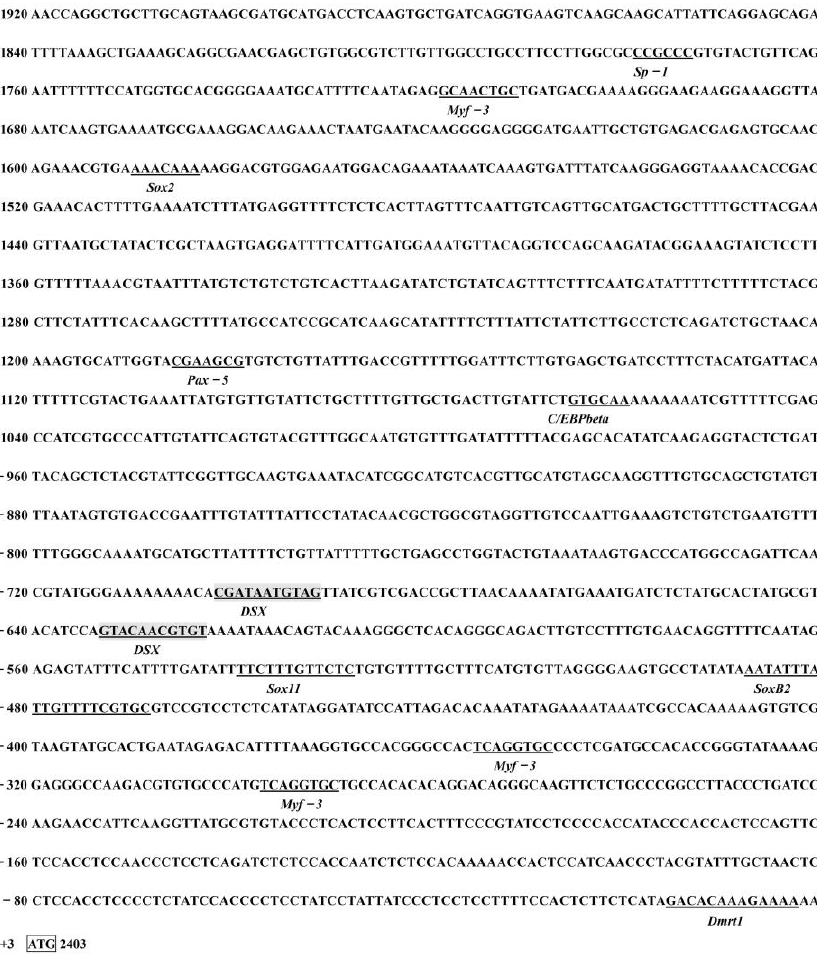
Figure 7. Sequence analysis and fragment amplification of IAG promoter in P. monodon . Bioinformatic prediction of potential cis-regulatory elements of transcription factors within the IAG gene promoter of P. monodon . Binding sites for binding various transcription factors are underlined, translation initiation sites are circled by boxes, and Dsx binding sites are shaded in